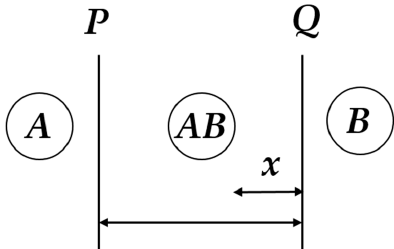
Figure 7. Schematic of 1D diffusion through a flat plate, where A and B are reactants, AB is the product interface, l is the thickness of the product layer, and x is the distance measured from interface Q into AB .